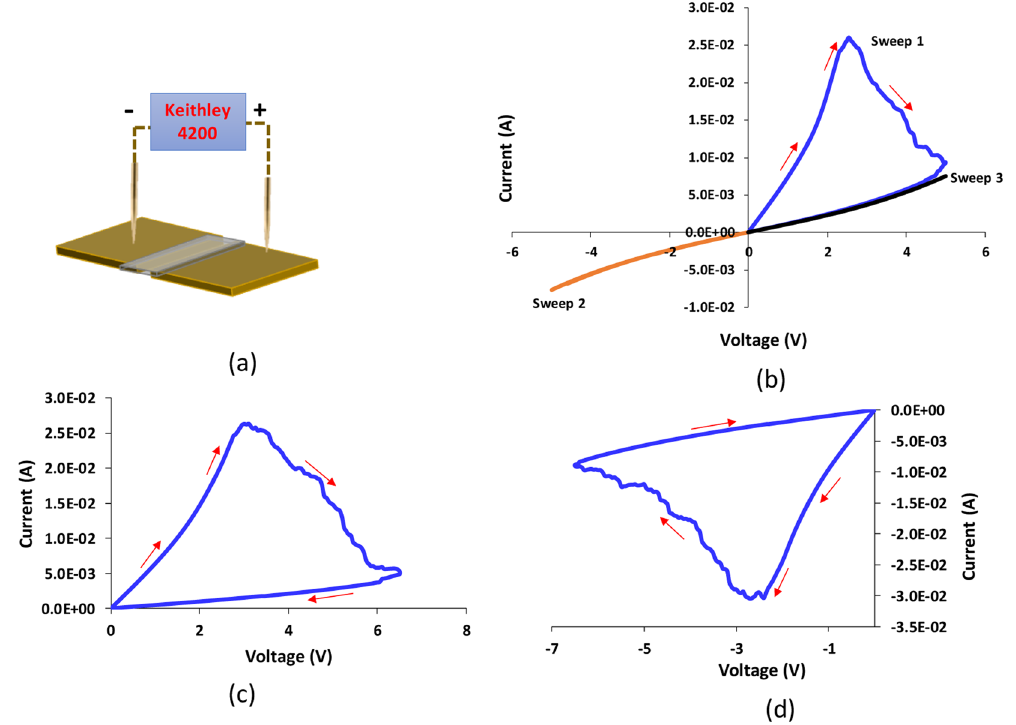
Figure 2. The data provided here is used to show the non-volatility of NeuroMem with the unipolar switching behavior. ( a ) A schematic to show the testing setup of NeuroMem. A chart illustrating the measured current across NeuroMem fresh devices with gap of 50 µ m (Drawing Software: Microsoft Powerpoint 2016) ( b ) under the application of three consecutive voltage sweeps, ( c ) under the application of + 6 V voltage sweep, ( d ) under the application of − 6 V voltage sweep.